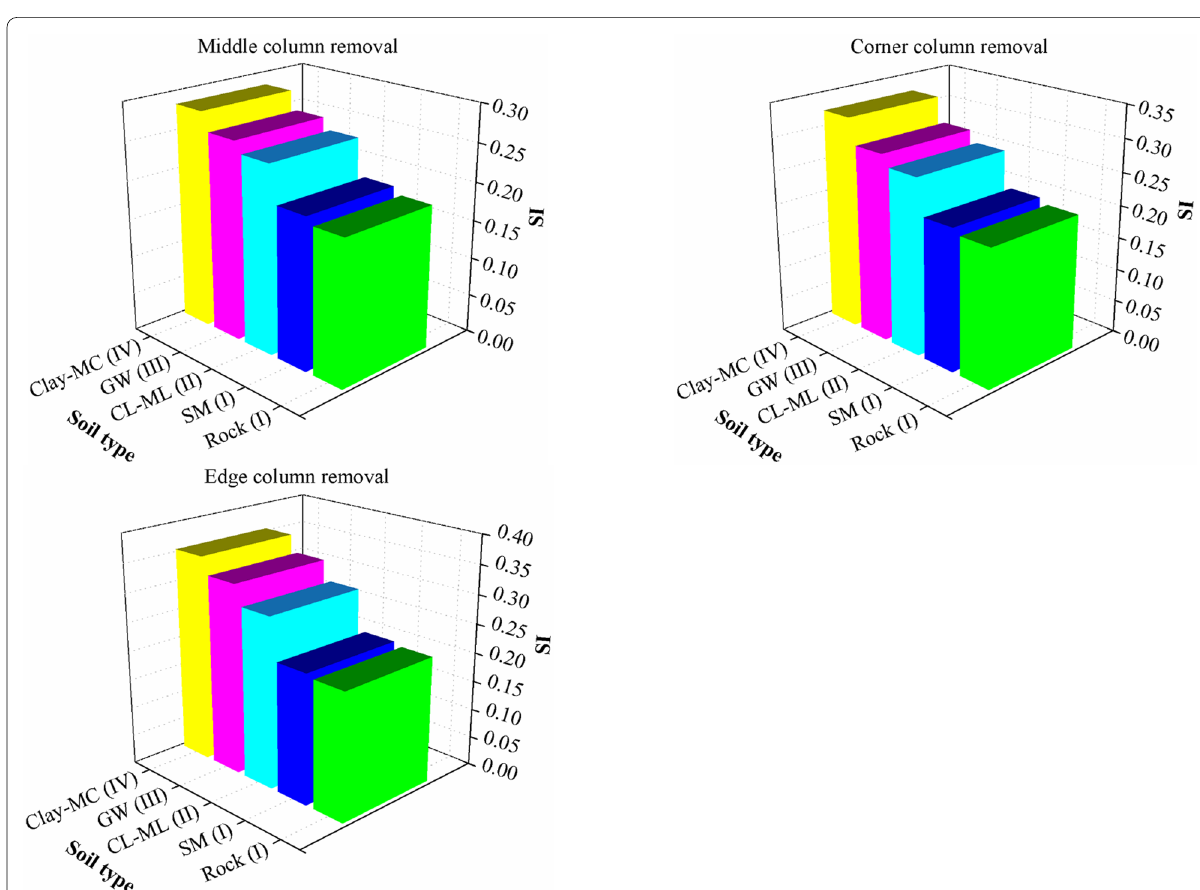
Fig. 14 The plot of the sensitivity index versus the type of substructure